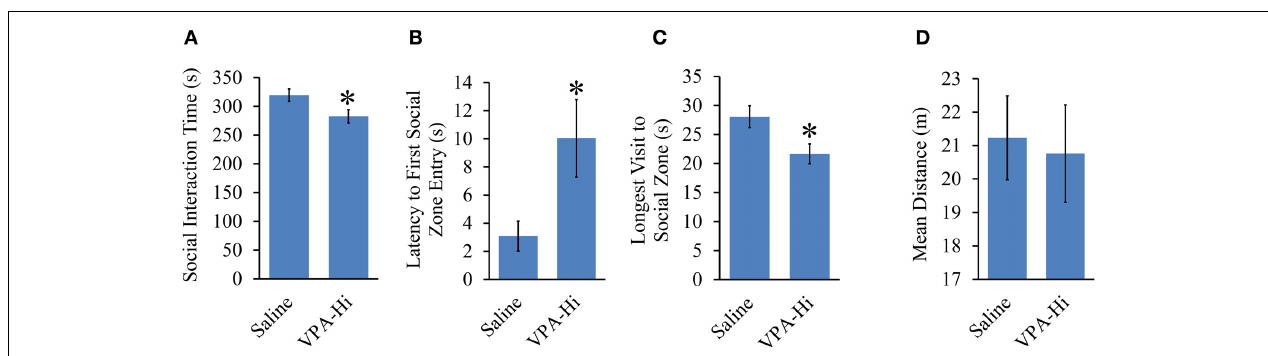
to saline animals. (C) The longest visit to the social interaction zone was reduced in VPA-Hi animals. (D) Mean distance traveled in the social interaction apparatus did not differ significantly between the groups. Data presented as mean ± s.e.m. ( ∗ p < 0 . 05